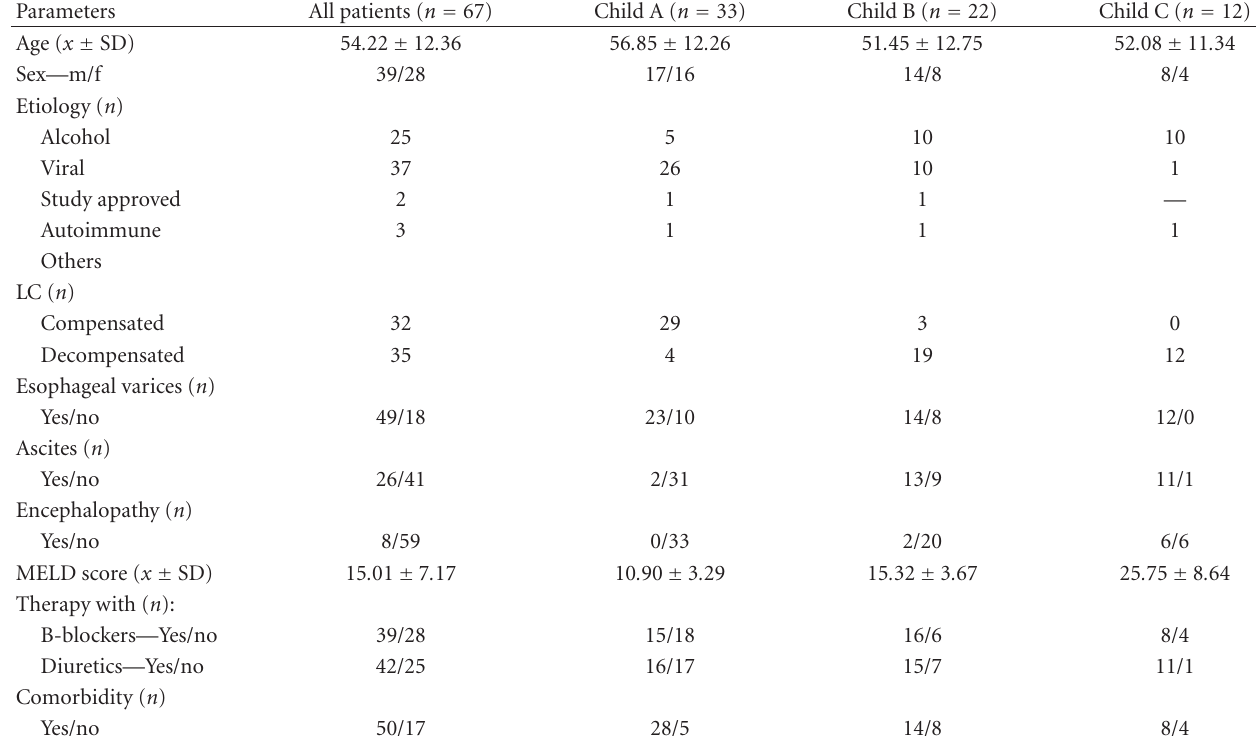
Table 1: Characteristics of patients with liver